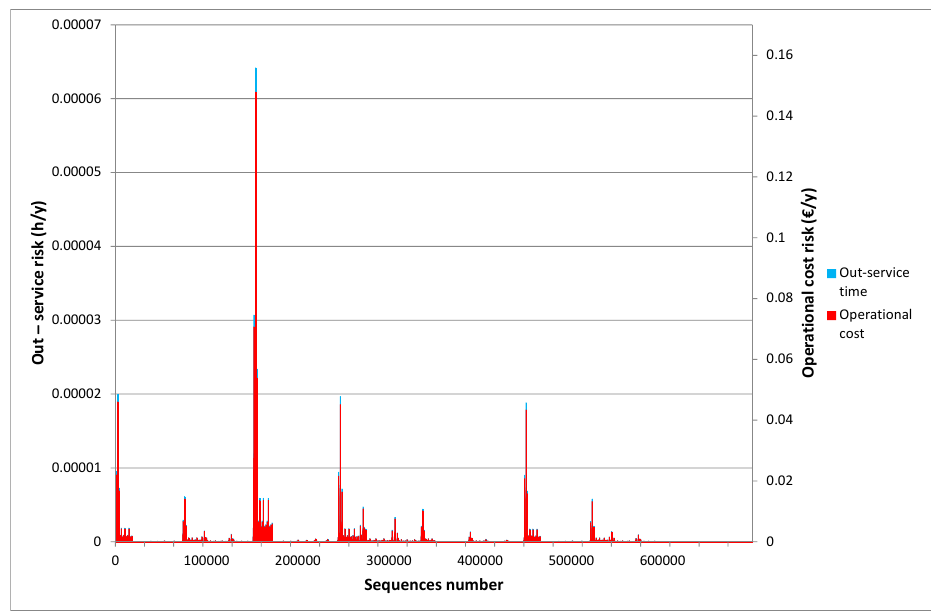
Figure 11. The risk of the sequences of events contain the catalyst sinterization for the fixed-bed based plant.